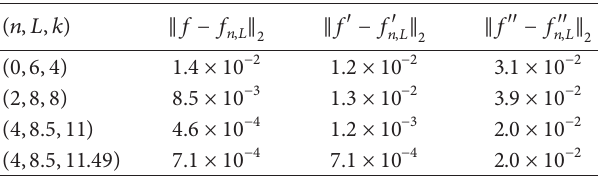
Table 2: 𝐿 2 -norm errors of 𝑓 𝑛,𝐿 (𝑘; 𝑥) and its derivatives 𝑓 󸀠 𝑛,𝐿 (𝑘;𝑥) and 𝑓 󸀠󸀠 𝑛,𝐿 (𝑘; 𝑥)